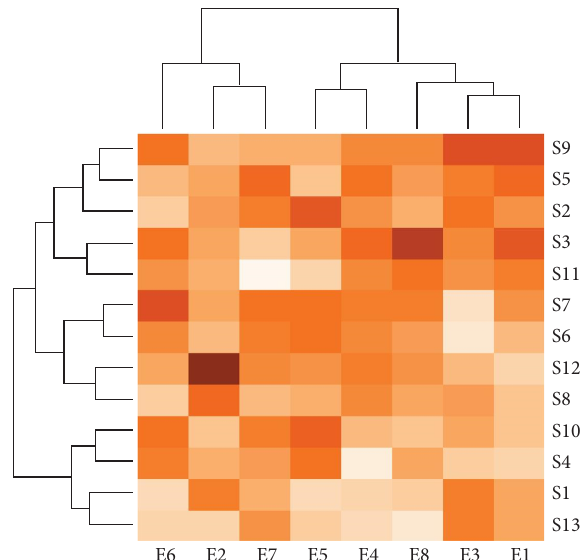
Figure 2: GEIs heatmap from eight environments on 13 soybean lines in Indonesia. E 1 � Ngawi (2016), E 2 � Banyuwangi (2016), E 3 � Banyuwangi (2017), E 4 � Ngawi (2017), E 5 � Probolinggo (2018), E 6 � Malang (2018), E 7 � Bantul (2019), and E 8 � Bogor